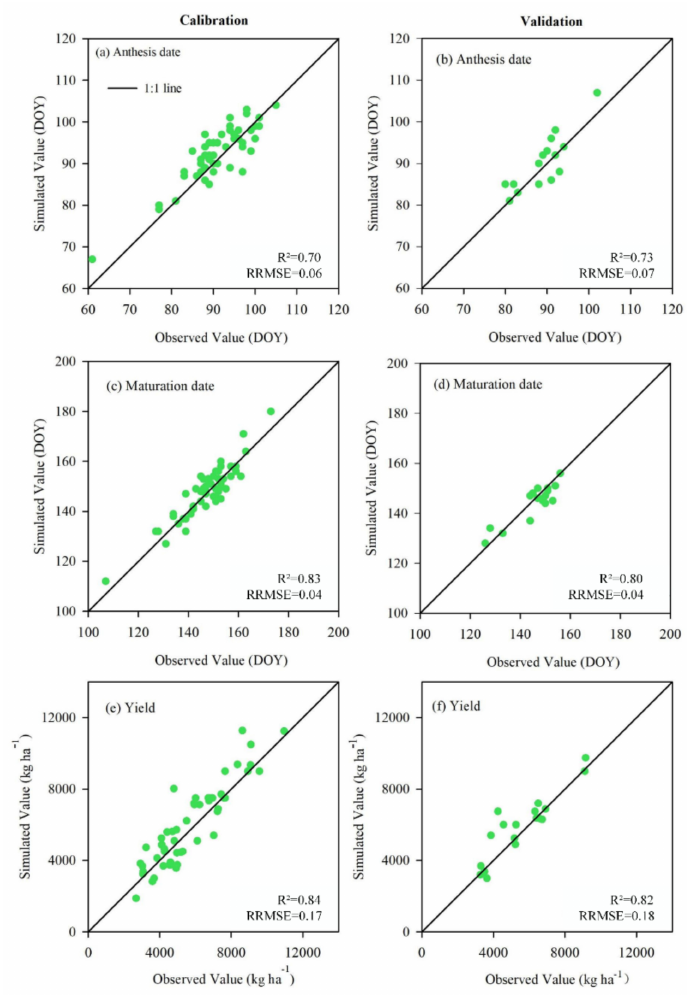
Figure 7. Comparison of the observed and simulated values of anthesis date, maturity date and yield for spring wheat for calibrated and validated processes.